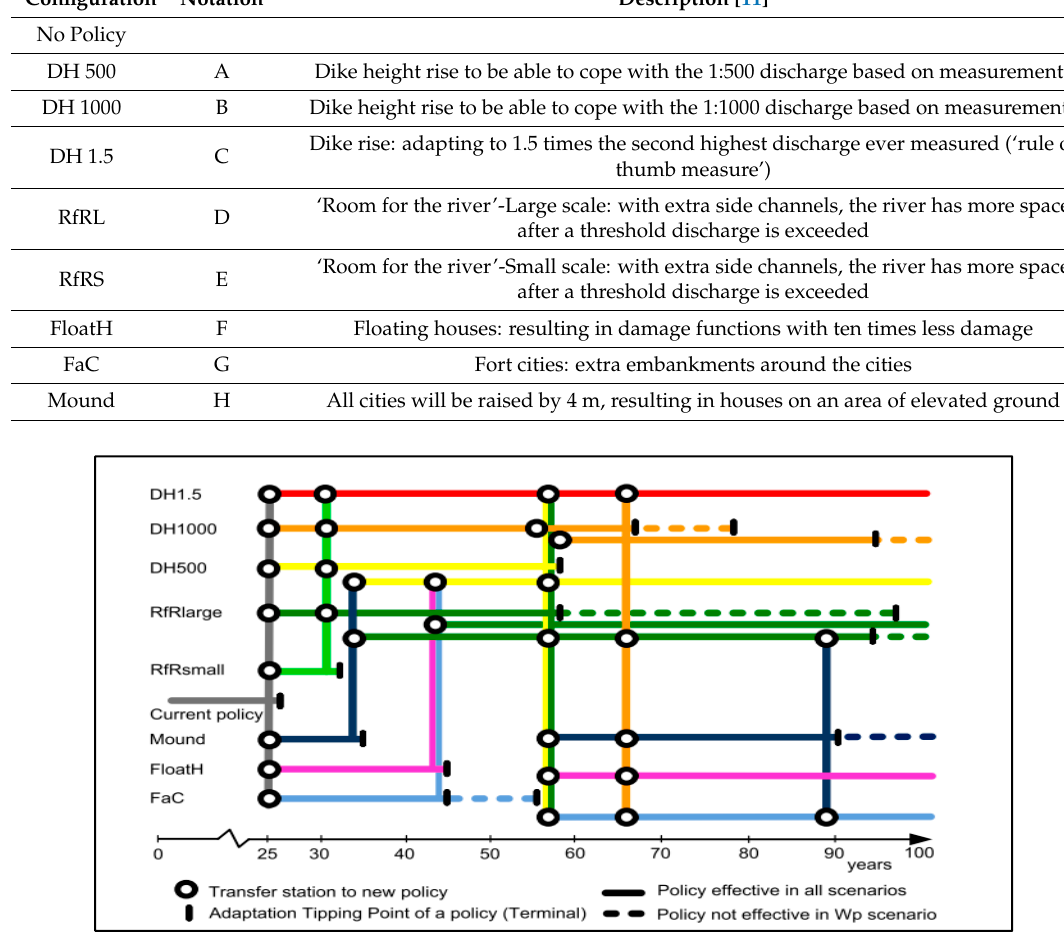
Table 2. Portfolio of Adaptation Actions, Waas case study (Table adapted from [11]).